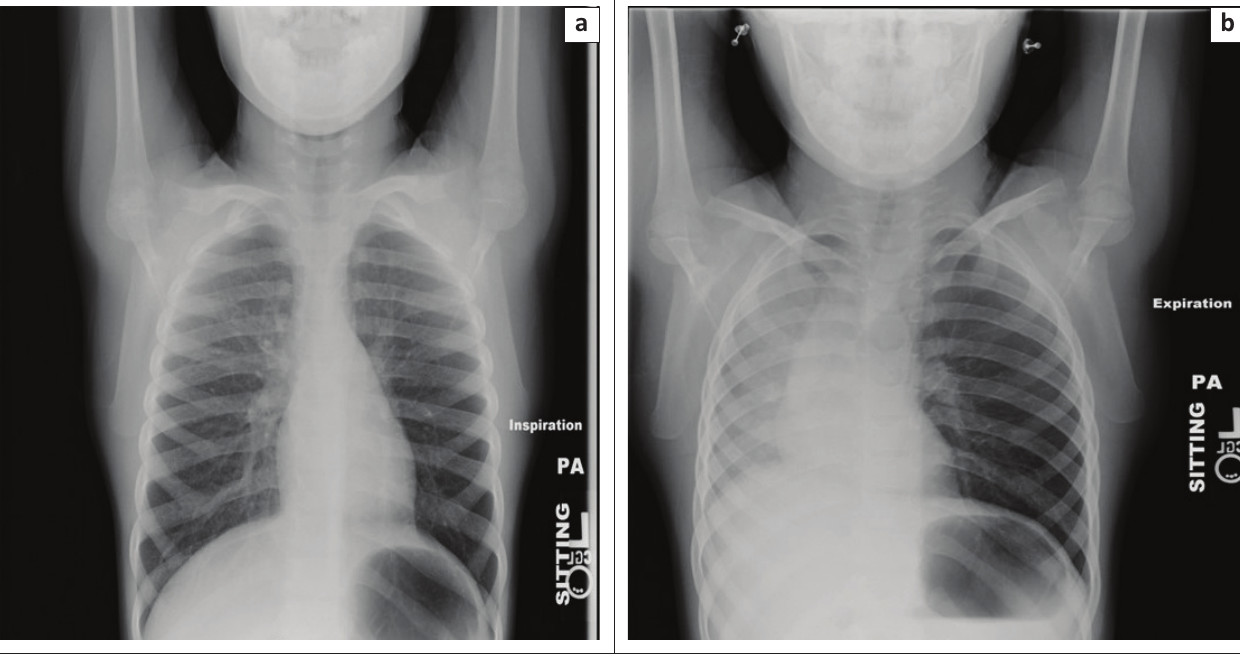
FIGURE 14: Images of a 6-year-old child who aspirated a candy wrapper into the left upper and lower segments of the left bronchus whilst eating a chocolate. The left lung appears to be hyperlucent on inspiration (a) and shows air trapping with mediastinal shift to the right on expiration (b).